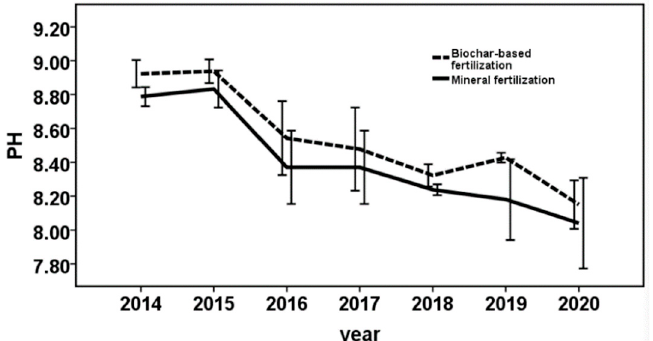
Figure 8. PH value (PH) variation for fertilization treatment over 7 years.